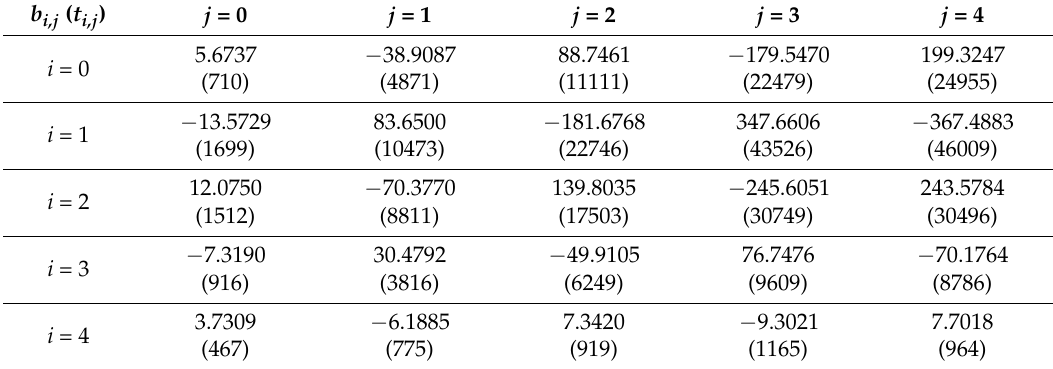
Table 7. Coefficients of the proposed model and their Student t -values provided in round brackets.